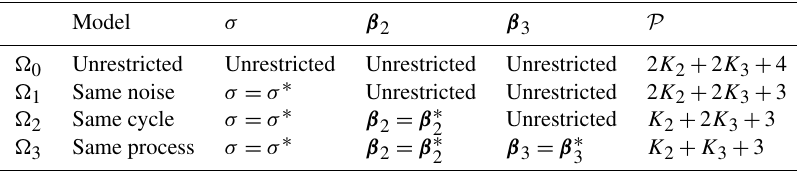
Table 1. Table summarizing the hypotheses considered in the hierarchical test procedure. P in the last column denotes the number of parameters